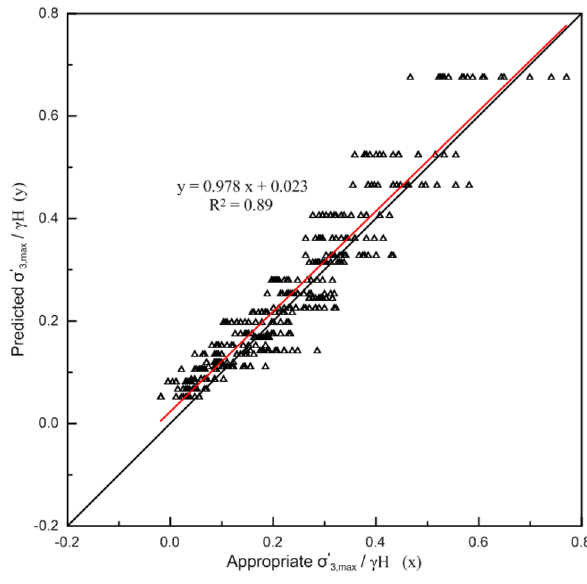
σ ′ 3,max γ H values and predicted values from Eq. (17).